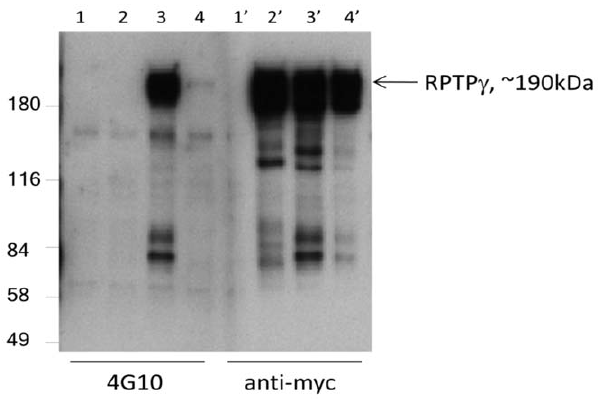
Figure 5. RPTP c substrate-trapping mutants in HEK293 cells. Phosphotyrosine-containing protein of about 190 kDa size ‘‘trapped’’ by RPTP c C1060S or RPTP c D1028A is RPTP c . Recombinant wild type RPTP c and substrate-trapped mutants were immunoprecipitated from transiently transfected HEK293F lysate with anti-myc mAb. Lanes 1 and 1 9 were IP product from pCDNA3 transfected cells, 2 and 2 9 were from wild type RPTP c transfected cells, 3 and 3 9 were from RPTP c C1060S transfected cells and 4 and 4 9 were from RPTP c D1060A transfected cells. Lane 1–4 were western reacted with anti-phosphotyrosine 4G10 mAb and lanes 1 9 -4 9 were with anti-myc mAb.